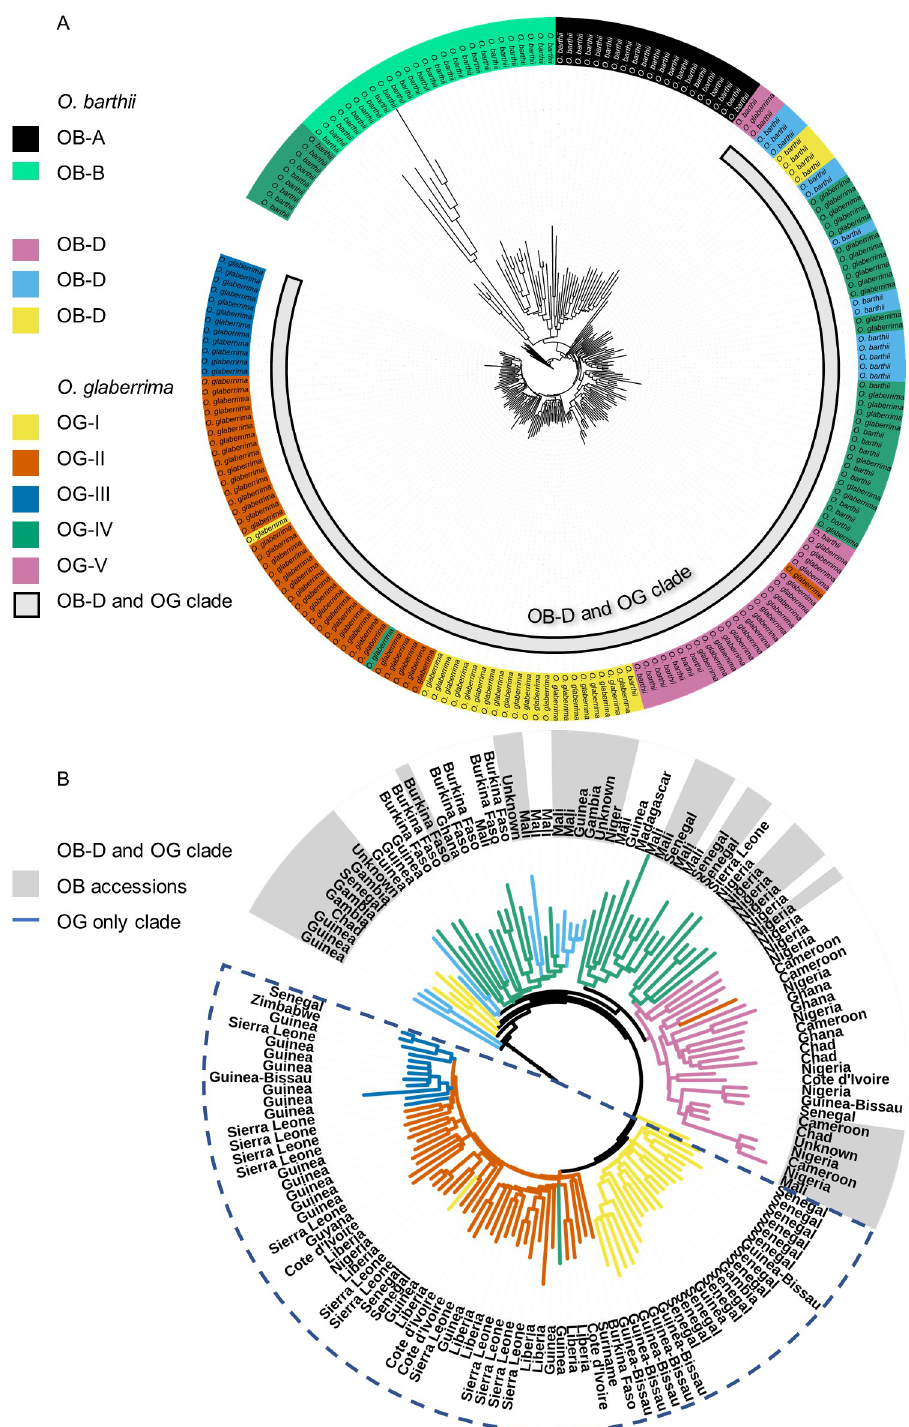
Fig 5. Neighbour joining (NJ) tree of O . barthii and O . glaberrima whole genome sequences, based on 3,923,601 genome-wide SNPs. A. NJ tree with all O . barthii (OB) and O . glaberrima (OG) accessions. Accessions are labelled by species and coloured according to their genetic cluster (K = 8). The grey bar labelled ‘OB-V and OG’ indicates the smallest monophyletic clade containing all O . glaberrima and its nearest wild relatives. B. Pruned NJ tree with only OB-V and OG accessions, representing the smallest monophyletic clade that contains all O . glaberrima and its nearest wild relatives. Branches are coloured according to genetic cluster (K = 8) and are labelled by country. OB-V accessions labels have a grey background. The dashed blue line surrounds the largest clade that contains only OG and no wild relatives.